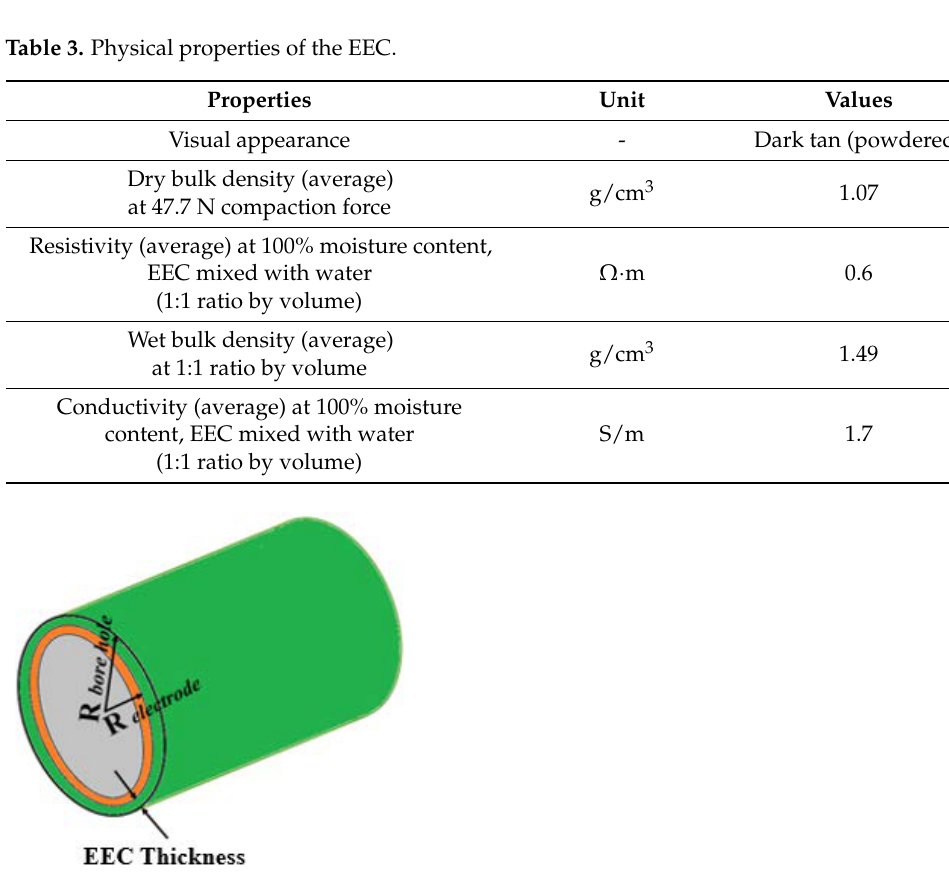
Figure 7. Cross-sectional view of the EEC modelled in the CDEGS software. Table 4. Details about the EEC required for modelling in